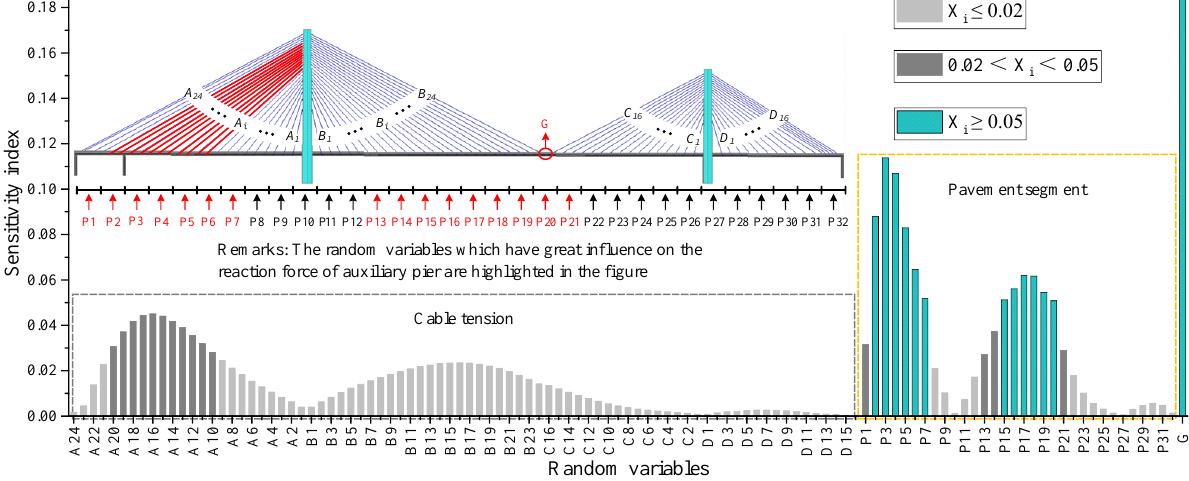
Figure 10. Sensitivity analysis results of the negative reactions.